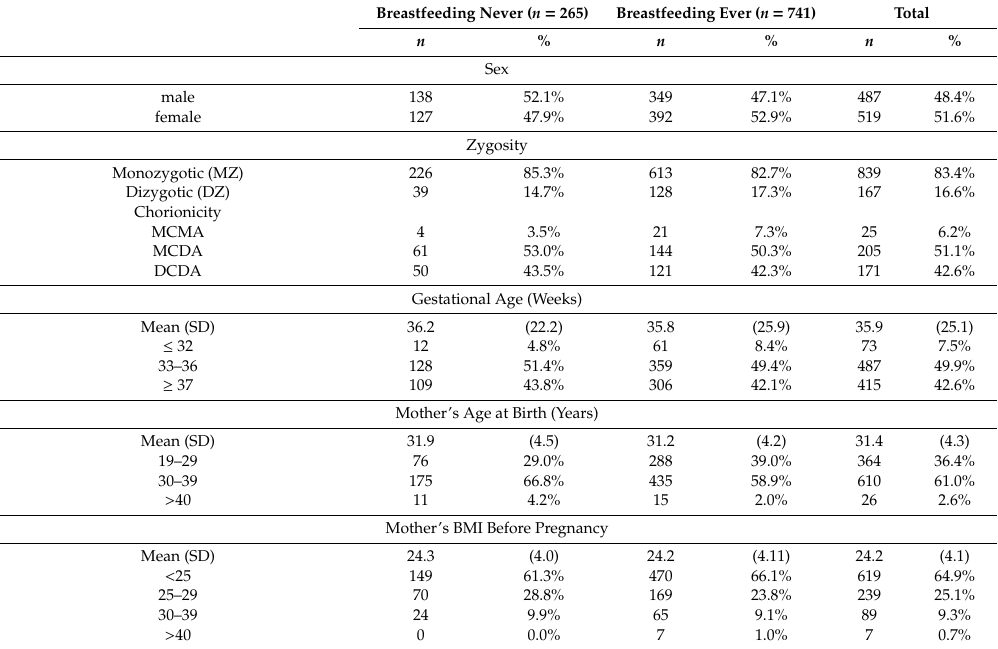
Table 1. Early life characteristics and breastfeeding in the Netherlands Twin Register (NTR) discovery sample ( n =